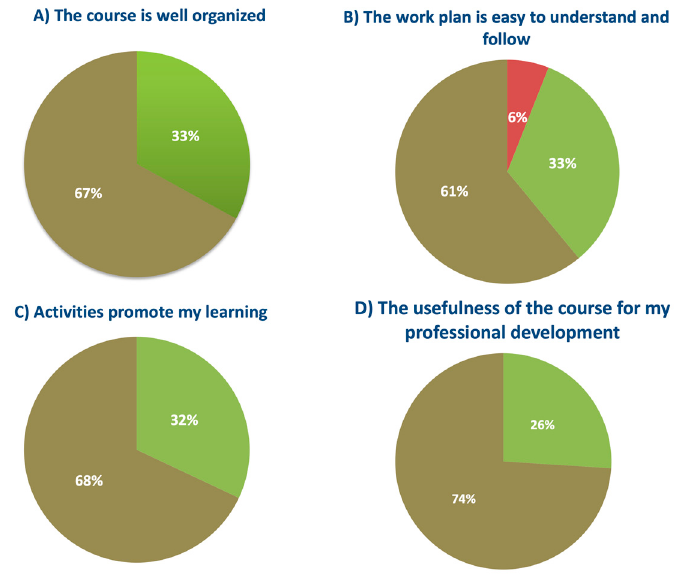
Figure 7. Overview of the most relevant questions: ( A ) “Q#1.2—The course is well organized,” ( B ) ” Q1.4—The work plan is easy to understand and follow,” ( C ) “Q#2.3—Activities promote my learn ‐ ing,” and ( D ) “Q#3.2—The usefulness of the course for my professional development.”